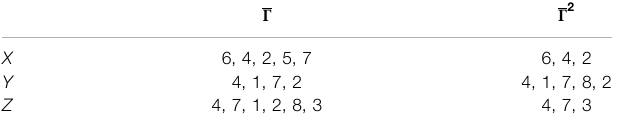
TABLE 2 | Patient groups with high variability from clusters in Figure 7